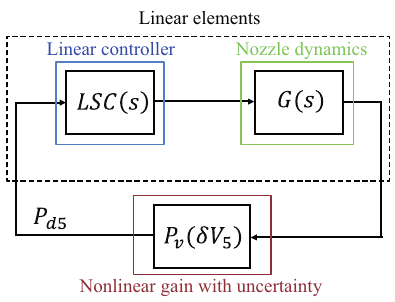
Figure 16. Autonomous representation of the pressure-control loop considering the exhaust gas speed non-linear static transformation with the model uncertainty limits δ min and δ max